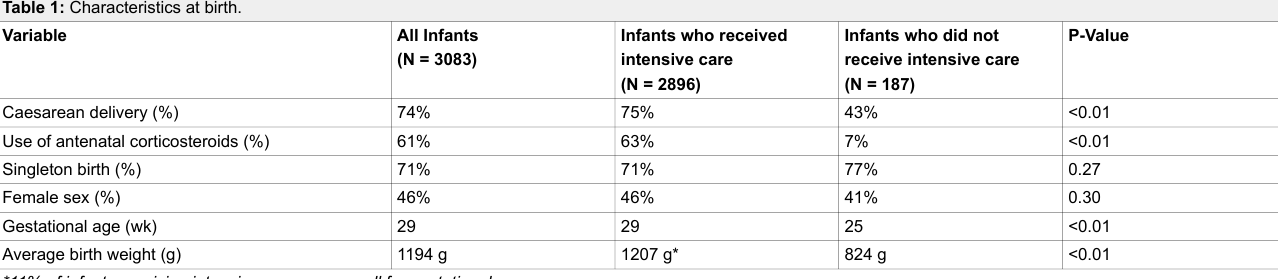
Table 1: Characteristics at birth.